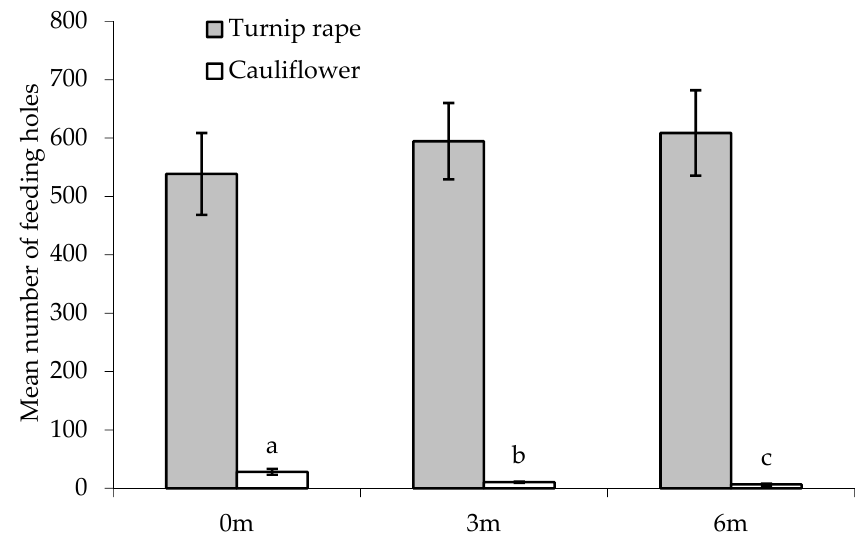
Figure 5. Number of flea beetle feeding holes (mean ± SE) on leaves of cauliflower plants and turnip rape plants separated by di ff erent distances. n = 10 for all means. Means with di ff erent letters (a–c) denote significant di ff erences between treatments. Table 3. Mean percentage feeding preference for border plants and total number of feeding holes in both border and ‘inner’ plants. Means are displayed with ± SEs. n = 10 for all means. Means with di ff erent letters (a–b) denote significant di ff erences between treatments within a